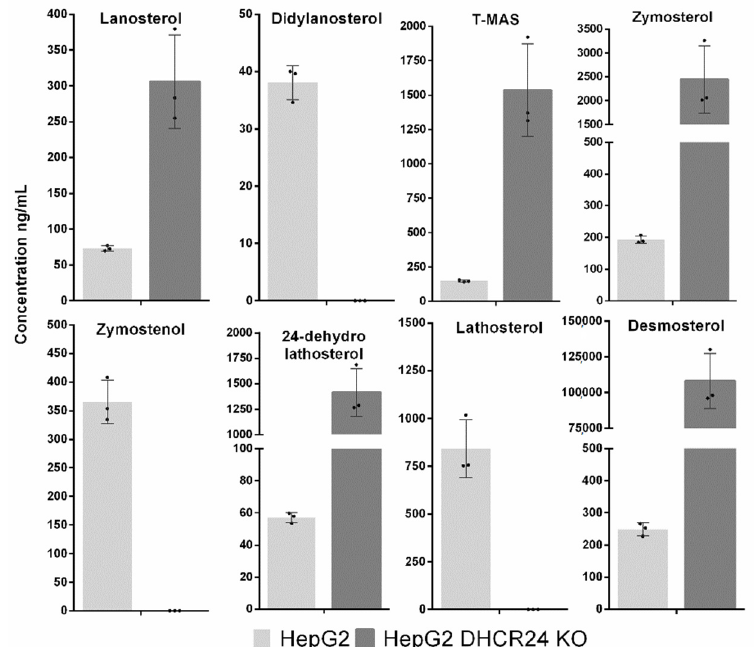
Figure 3. Concentrations of sterol intermediates isolated from HepG2 and HepG2 DHCR-KO cell lines. All concentrations are calculated as ng / mL per 10 7 , to normalize sterol concentration based on the number of counted cells. All data are represented as mean with SD, black dots represent individual measurements. Table 2. Concentration of sterols isolated from HepG2 and HepG2 DHCR24 KO cell cultures. HepG2 HepG2 DHCR24 KO Statistical n = 3 n = 3 Significance with Sterol Measured Unpaired t -Test *Concentration Mean (ng / mL)